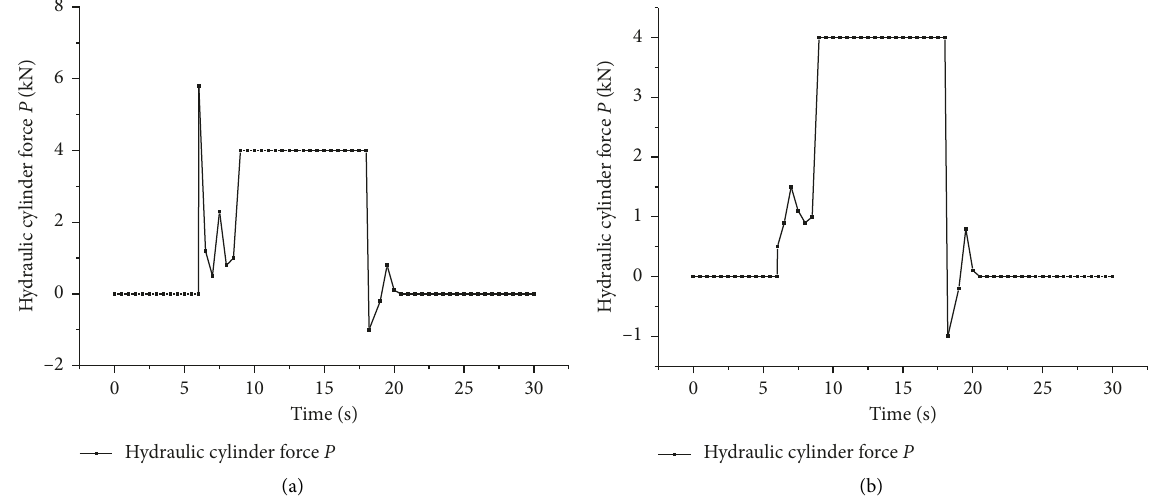
Figure 10: Pressure and output force curves of the two chambers of the hydraulic cylinder. (a) Direct switching control. (b) Fuzzy switching